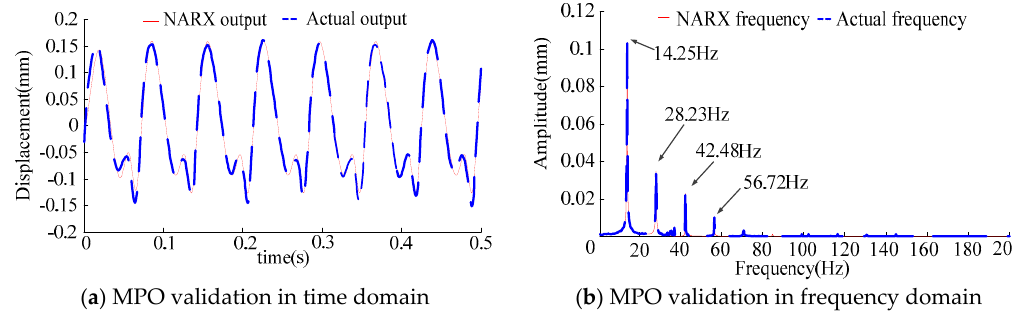
Figure 13. Output comparison in time and frequency domain of the test.